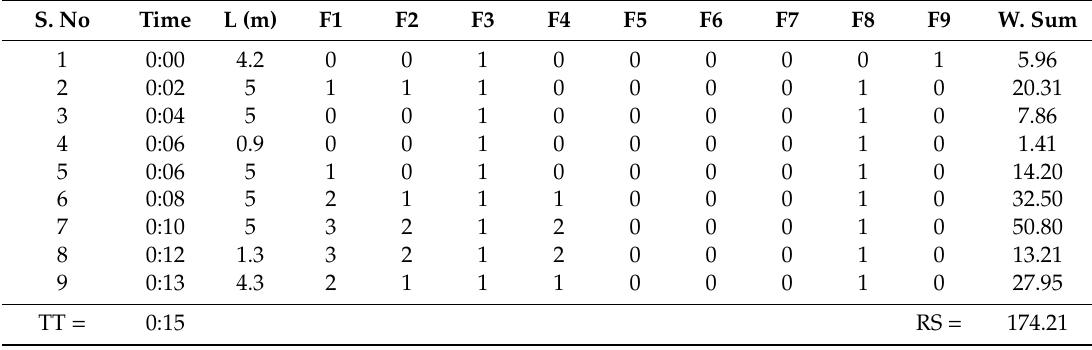
Table 7. RS calculation for Route 2 (including the second fire).